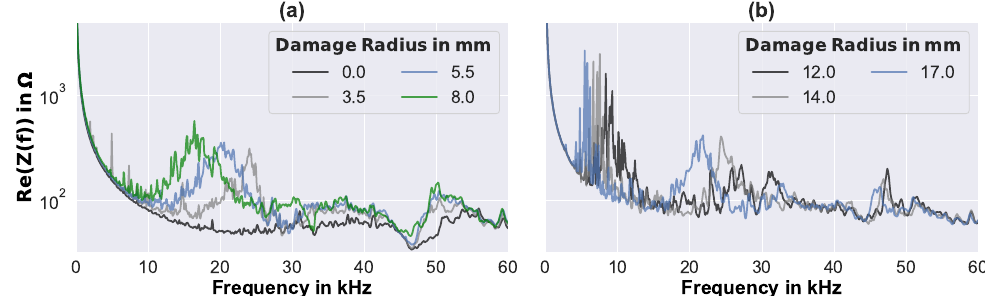
Figure 7. Examples of measured EMI spectra of the sandwich plate without any artificial disturbance, and with different perfectly circular debondings of ( a ) small size, and ( b ) middle-range size.